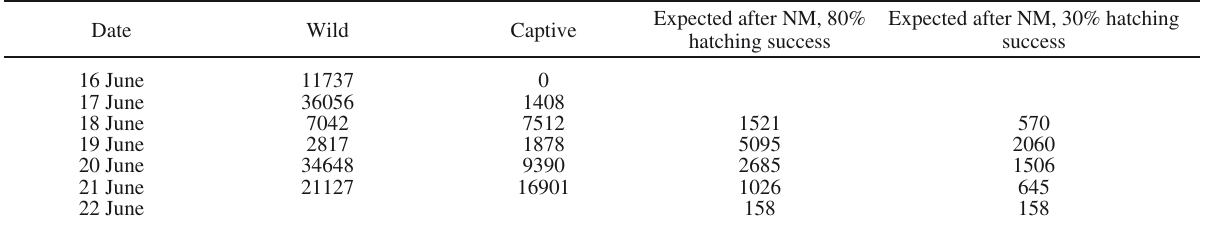
Table 1. – Observed egg densities collected by the two cages (wild and captive). The expected egg density after applying the natural mortality (NM) curve and assuming 80% and 30% hatching success are also indicated. Wild